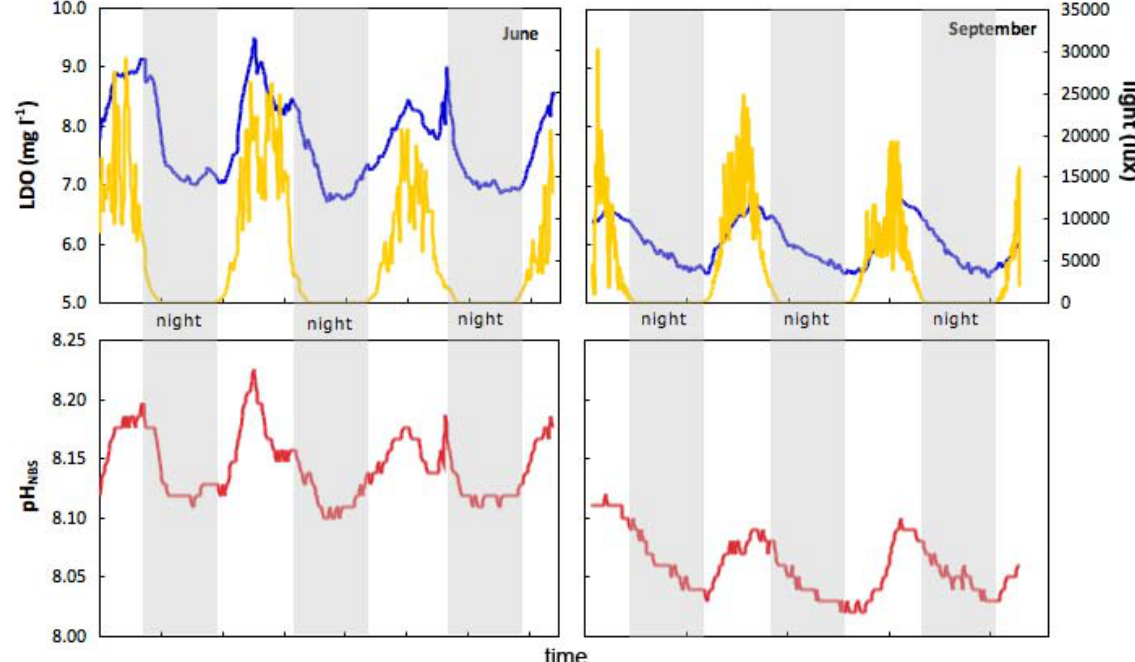
Fig. 2. Diurnal profiles of light levels (lux) and of oxygen concentration (mgL − 1 ; upper panels) and pH (lower panels) in the canopy during the June (left panels) and September campaigns (right panels) in